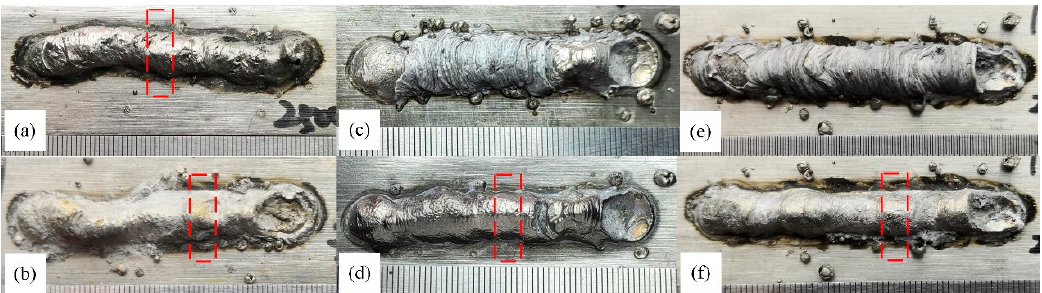
Figure 11. The effect of filling rate on weld appearance with different filling rate wires. ( a ) 15%; ( b ) 20%; ( c ) 24% (with slag); ( d ) 24% (without slag); ( e ) 28% (with slag); ( f ) 28% (without slag).